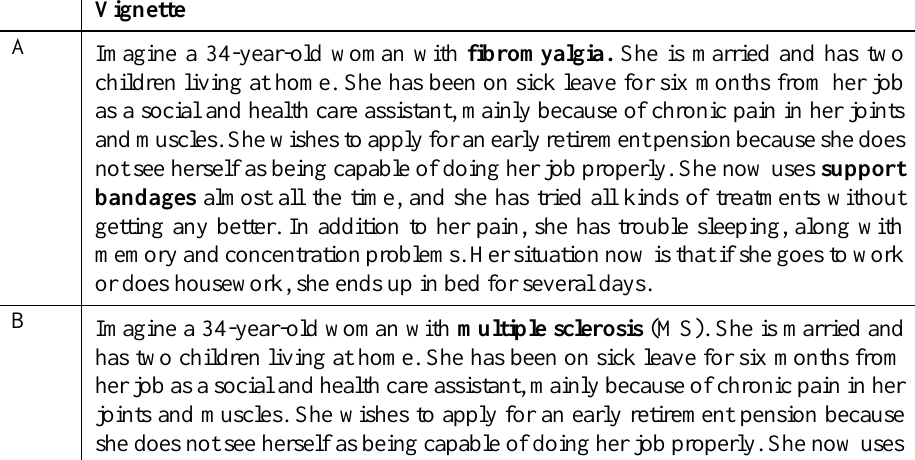
Differences between salient features in the three vignettes